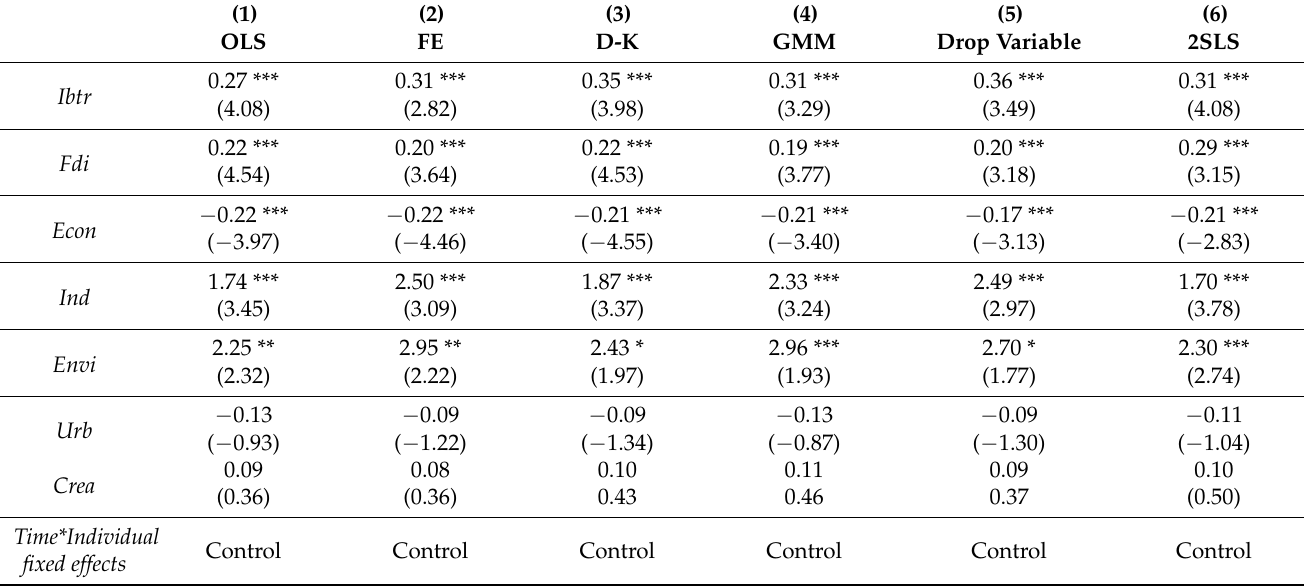
Table 2. Benchmark regression